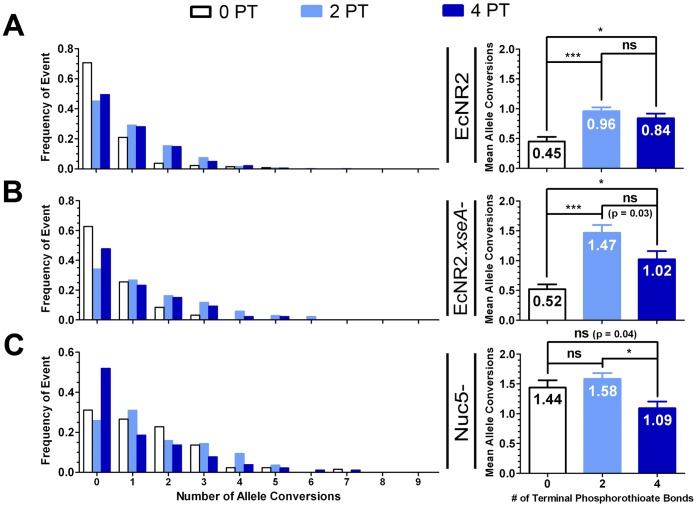
Effect of Phosphorothioate Bonds on CoS-MAGE Performance.The effect of oligo phosphorothioation on the CoS-MAGE performance of the various nuclease knockout strains was studied. Variants of recombineering oligo Set 1 (described in Figure 3) with no PT bonds (0 PT) and four PT bonds on both ends (4 PT) were compared with the initial version of Set 1, which had two PT bonds on both ends (2 PT). Recombination was performed with cat co-selection as prior. For EcNR2 (A), n = 133 (0 PT), n = 319 (2 PT), n = 186 (4 PT). For EcNR2.xseA
− (B), n = 94 (0 PT), n = 92 (2 PT), n = 86 (4 PT). For nuc5− (C), n = 132 (0 PT), n = 257 (2 PT), n = 183 (4 PT). Data shown in the right panels are presented as the mean with the standard error of the mean. Statistical significance is denoted using a starred system where ns denotes a non-significant variation, * denotes p<0.003, ** denotes p<0.001, and *** denotes p<0.0001.